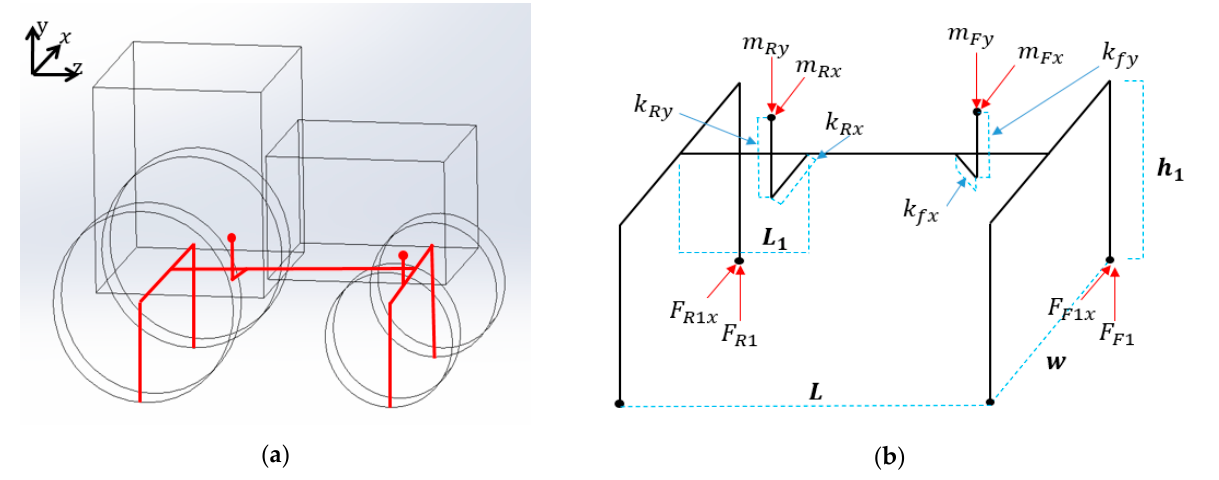
Figure 3. Tractor model for theoretical analysis: ( a ) Simplification of the general tractor model; ( b ) Free body diagram.